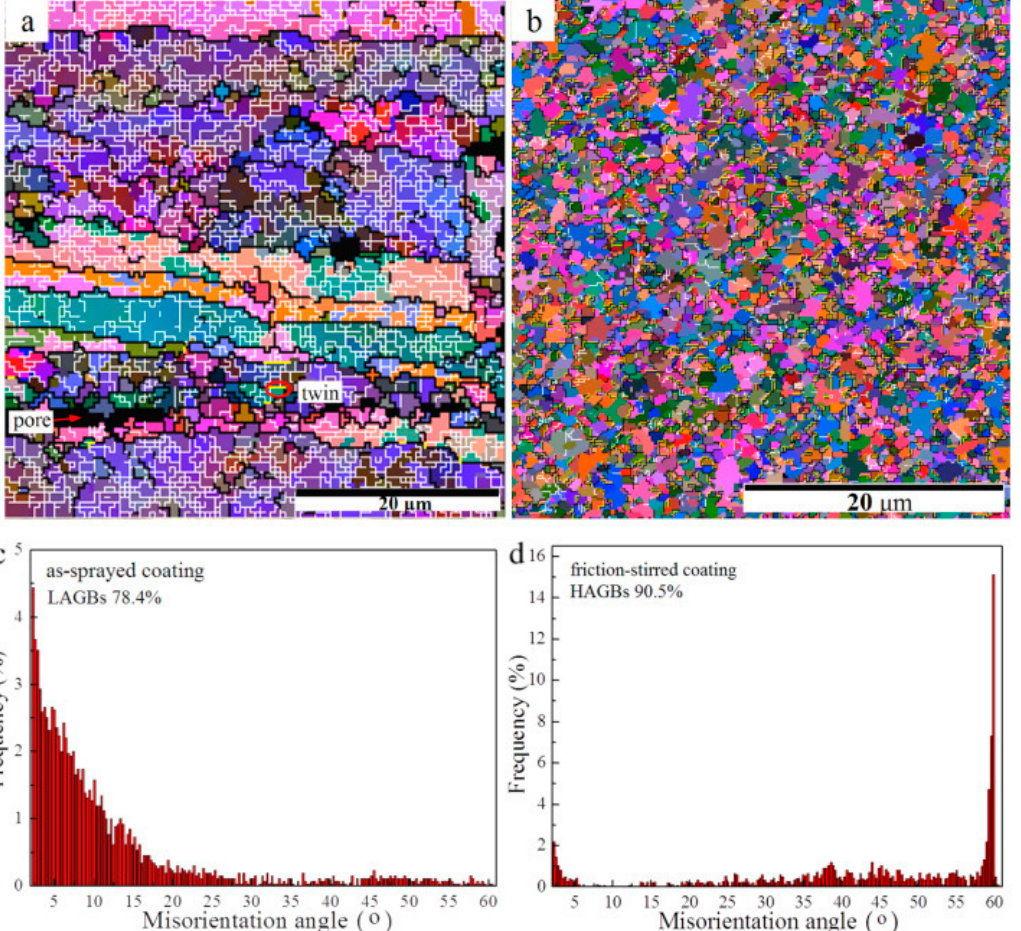
Figure 6. ( a – b ) EBSD mappings of ( a ) as-sprayed and ( b ) FSPed Cu-Zn alloy coatings, where the black, white and yellow lines are corresponding to the HAGBs ( θ ≥ 15°), LAGBs (15° > θ >2°), and Twin Bands, respectively. ( c – d ) Misorientation angle distributions in ( c ) as-sprayed and ( d ) FSPed coatings (adapted from reference [59] , with permission from © Elsevier).